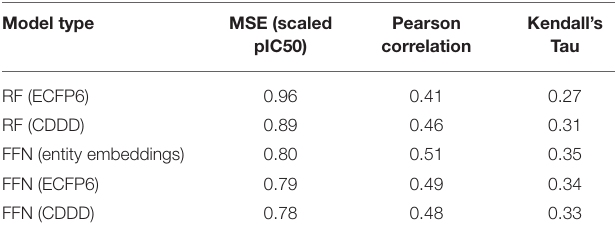
Pearson Kendall’s pIC50) correlation Tau